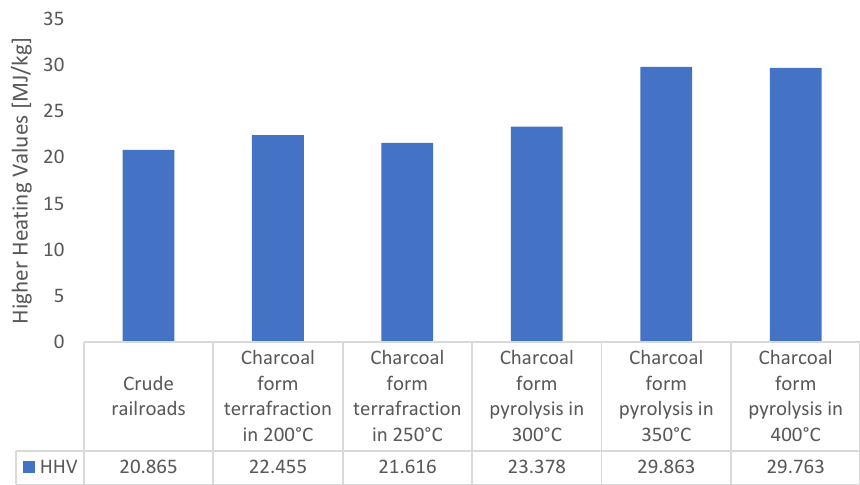
Figure 10. The higher heating value of the raw material (20 °C) and the chars obtained with different final temperatures.